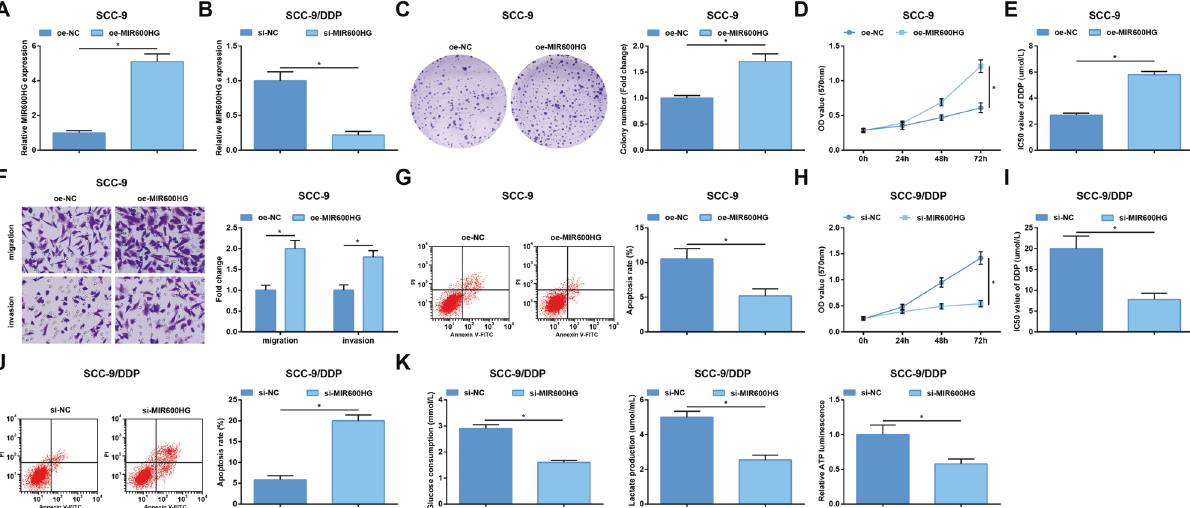
Fig. 2 Effects of MIR600HG on growth, DDP sensitivity, and glycometabolism of OSCC cells. A MIR600HG expression in SCC-9 cells after transfection of oe-NC or oe-MIR600HG was assessed using RT-qPCR. B The knockdown effect after MIR600HG siRNA transfection was con fi rmed by RT-qPCR in SCC-9/DDP cells. C Colony formation ability of SCC-9 cells was determined using colony formation assay. D viability of SCC-9 cells was determined using MTT assay. E IC 50 of SCC-9 cells was determined using MTT assay. F Migration and invasion of SCC-9 cells was detected using Transwell assay. G Apoptosis of SCC-9 cells was detected using fl ow cytometry. H Viability of SCC-9/DDP cells was determined using MTT assay. I IC 50 of SCC-9/DDP cells was determined using MTT assay. J Apoptosis of SCC-9/DDP cells was detected using fl ow cytometry. K Glycometabolism of SCC-9/DDP cells was analyzed; N = 3; * P < 0.05; the data were expressed as mean ± standard deviation and t -test was used to analyze